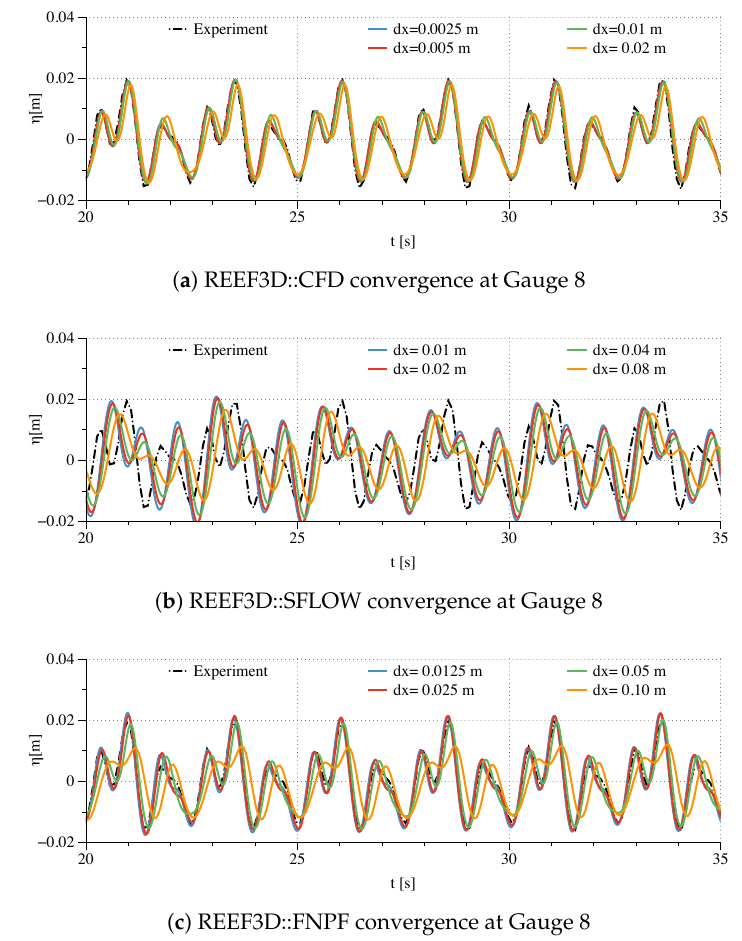
Figure 4. Convergence study on horizontal cell sizes at wave gauge 8 for the simulations of wave propagation over a submerged bar. ( a ) REEF3D::CFD grid convergence, ( b ) REEF3D::SFLOW grid convergence, ( c ) REEF3D::FNPF grid